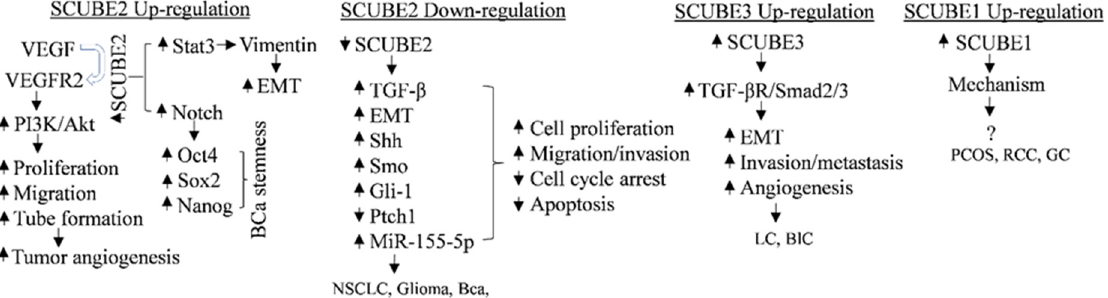
Figure 5. Mechanism of SCUBE family in cancers and cancer stem cells in a contextual manner. VEGF, vascular endothelial growth factor; VEGFR2, vascular endothelial growth factor receptor 2; PI3K/Akt, phosphoinositide 3-kinase/protein kinase B; EMT, epithelial–mesenchymal transition; BCa, breast-cancer; Shh, sonic hedgehog; Ptch, patched homolog; Smo, smoothened; Gli, Gli family zinc finger; MMP-2/9, matrix metalloproteinase 2/9; Stat3, signal transducer and activator of transcription factor 3; TGF, transforming growth factor- β ; NSCLC, nonsmall-cell lung cancer; LC, lung cancer; BlC, bladder cancer; PCOS, polycystic ovary syndrome; RCC, renal-cell cancer; GC, gastric cancer. Table 3. Role of SCUBE1/2/3 in cancer.